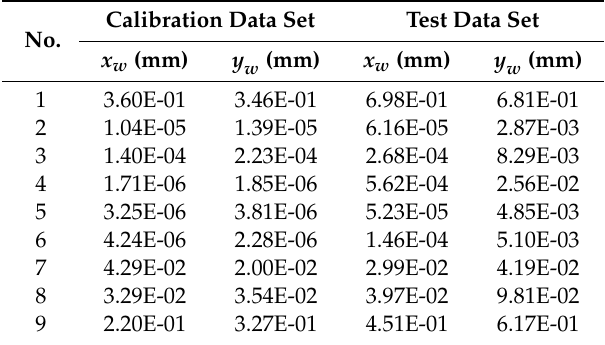
Table 3. Fitting errors with di ff erent values of the shape parameter.